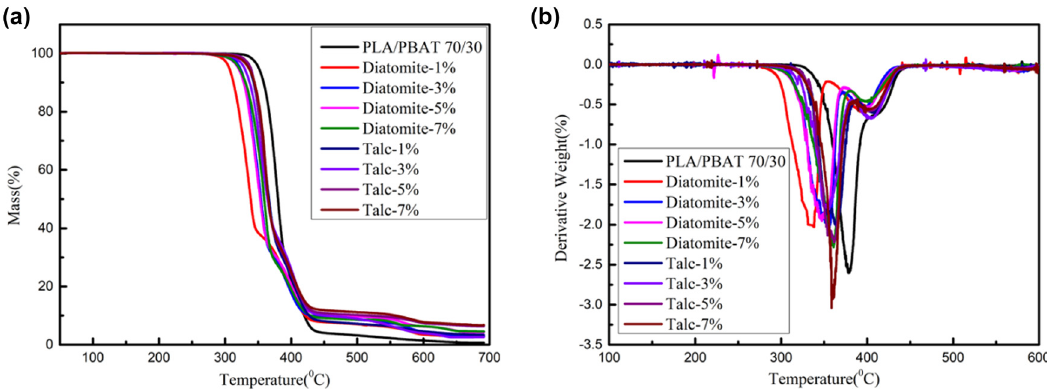
Figure 3: ( a ) TGA curves and ( b ) DTG curves of the samples under nitrogen fl ow.